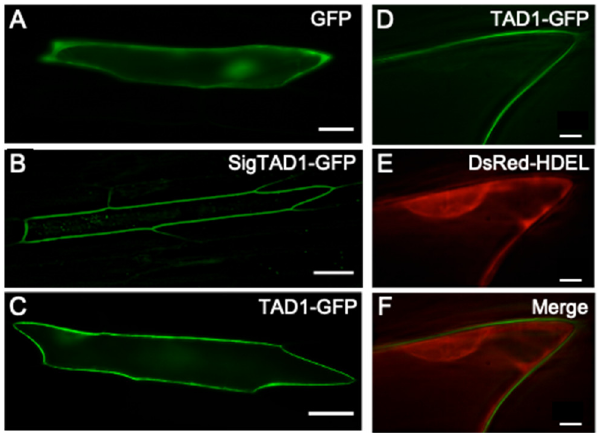
Figure 2. Subcellular localization of GFP fusion proteins in onion epidermal cells. Fluorescent images of the cells transformed with GFP vector ( A ), SigTAD1-GFP ( B ), and TAD1-GFP ( C ). Scale bar for A = 20 µm; scale bar for B and C = 50 µm. ( D , E ) Apoplastic localization of the TAD1 protein in onion epidermal cells. Fluorescent images of the cells co-bombarded with TAD1-GFP ( D ) and an ER marker DsRed-HDEL ( E ). ( F ) A merged image of D and E. Scale bar = 10 µm.